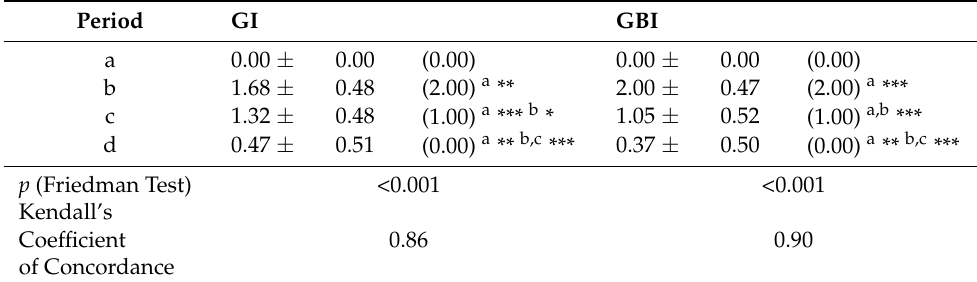
Table 1. GI and GBI values during the study period.